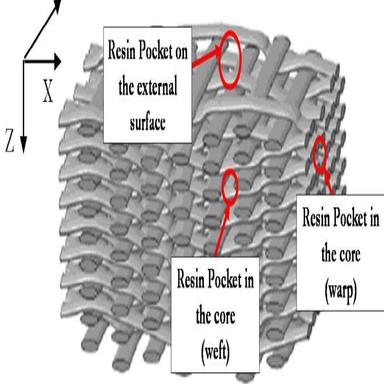
Scheme of a 3D interlock carbon-fiber reinforcement similar to the one used in this study .